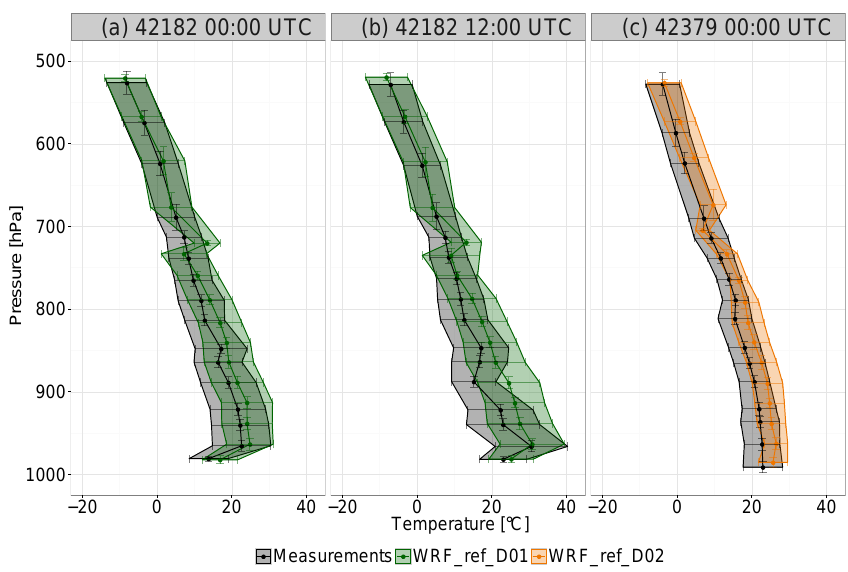
Figure 3. Averaged vertical profiles derived from radiosonde data and WRF simulations for temperature ( ◦ C) for the period of January– June 2013. The figures show the results for station 42182 at 00:00 (a) and 12:00UTC (b) and station 42379 at 00:00UTC (c) . The shaded areas show the standard deviation, indicating the variability over the whole time period within each bin.